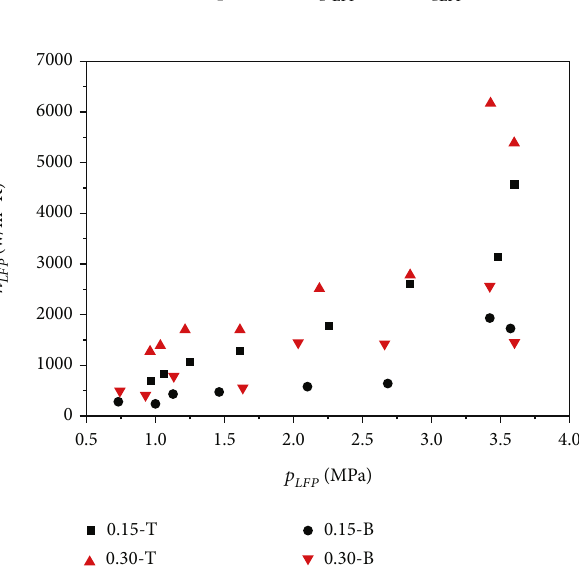
Figure 12: Experimental p